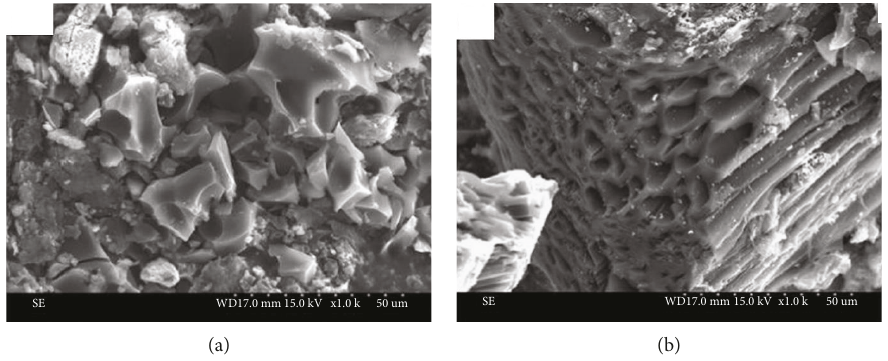
Figure 4: (a) The SEM images of SBAC (a) without corn bar; (b) with corn stalk